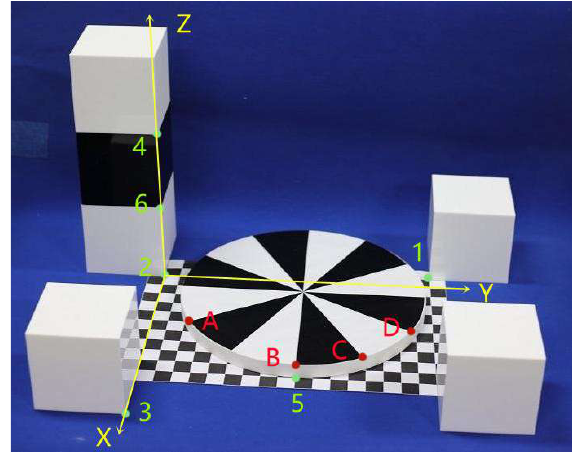
Figure 5. The experimental model.